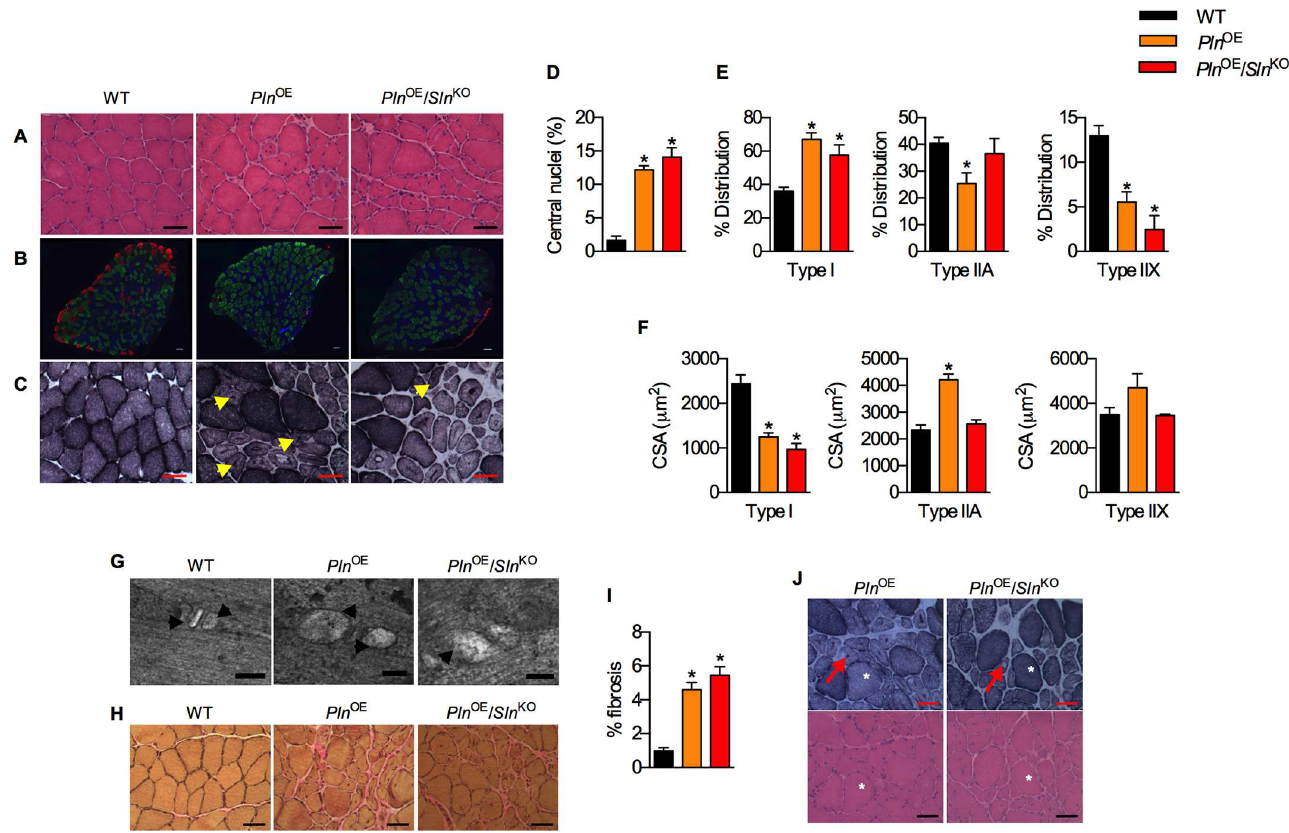
Fig 3. SLN does not contribute to CNM pathology in Pln OE mice. Representative H&E (A), immunofluorescent (B), and SDH (C) stainedsections showingthe CNM phenotype of elevated central nuclei (D), type I fiber predominance (E) and type I fiber hypotrophy and type II fiber hypertrophy(F), and central aggregation of oxidativeactivity (yellowarrows in C) (n = 4–6 per genotype). (G) Transmission electron micrographs illustrating triad disruptionswith swollensarcoplasmic reticulumin both the Pln OE and Pln OE / Sln KO soleus muscles. Arrowheadspoint to the swollensarcoplasmic reticulumwith corresponding area. Van-Giesons staining (H) quantified with imageJ (I) revealsgreater endomysial fibrosis the Pln OE and Pln OE / Sln KO soleus muscles comparedwith WT (n = 4 per genotype). (J) Representative SDH-stained and H&E-stained sections displayingcore-like aspects in the Pln OE and Pln OE / Sln KO soleus muscles that cannot be explained by the presenceof an artifact or vacuole.Arrows point to the core-like aspect and asterisks depict the same fiber within serial sections. * Significantly different from WT using a one-wayANOVA with a Tukey’s post-hoc, p (cid:20) 0.05. All values are means ± SEM. CSA, cross-sectional area. All scale bars are set to 50 μ m except for (G) where scale bars are set to 100